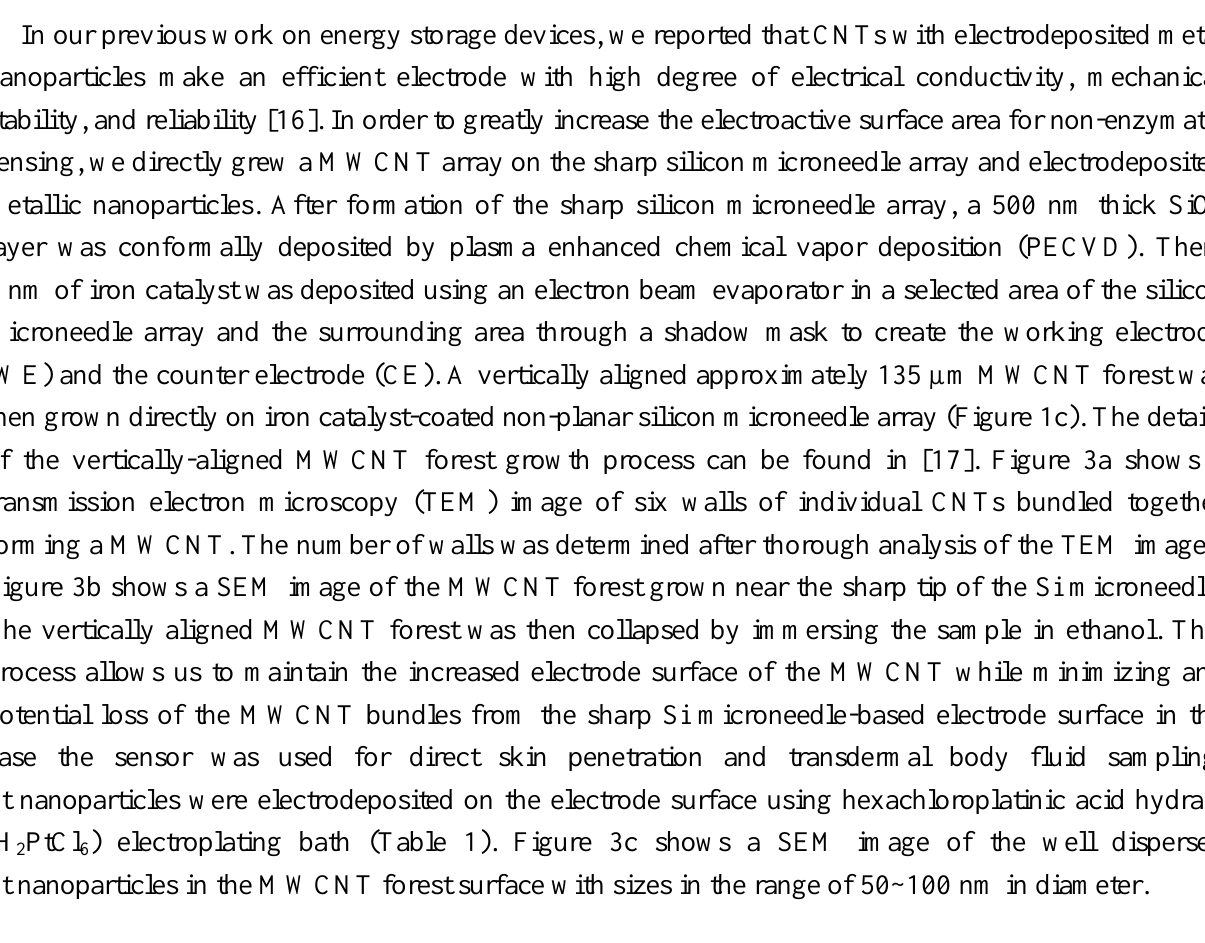
Table 1. Chemical composition of platinum electrodeposition